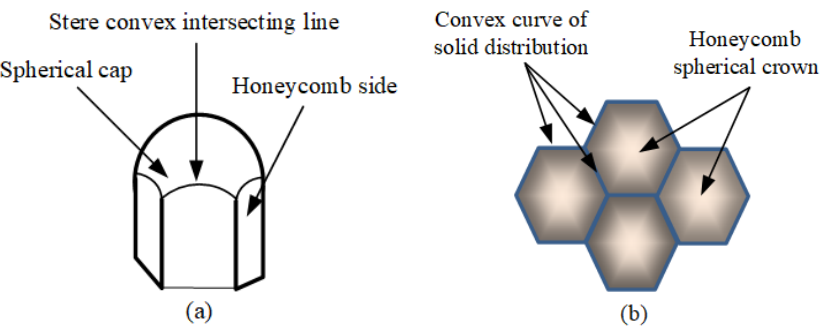
Figure 2. Schematic diagram of ( a ) the “honeycomb monomer” and ( b ) its combination.